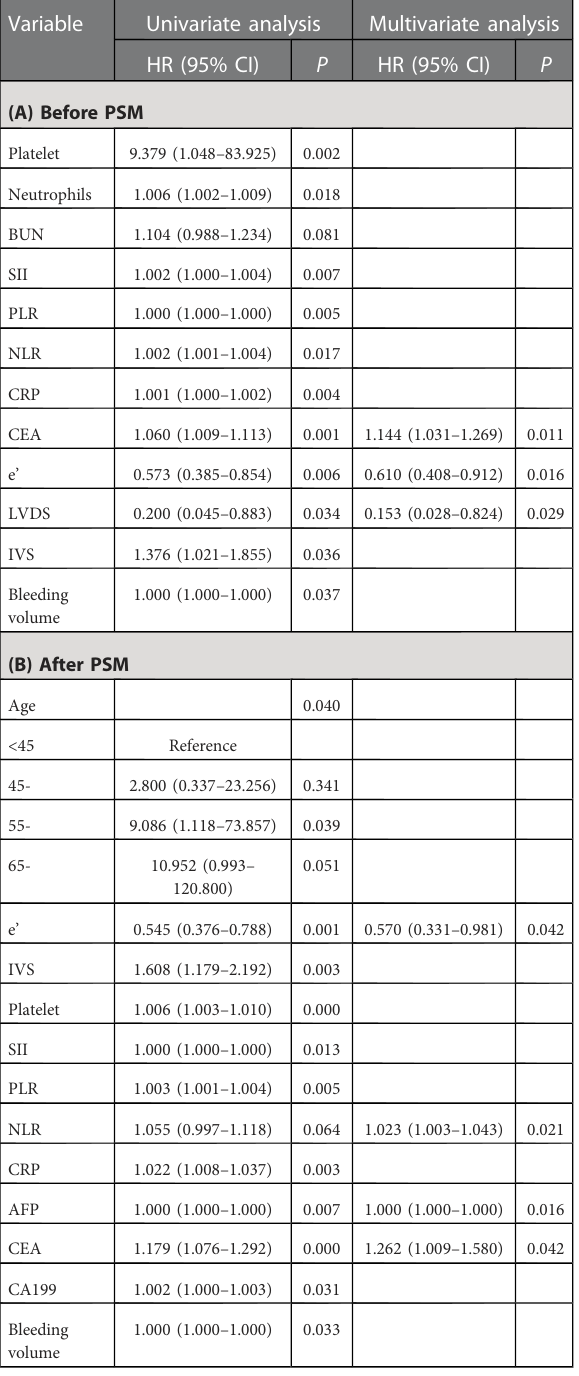
TABLE 7 Univariable and multivariable cox proportional hazard regression analysis of 1-year mortality post-LT.